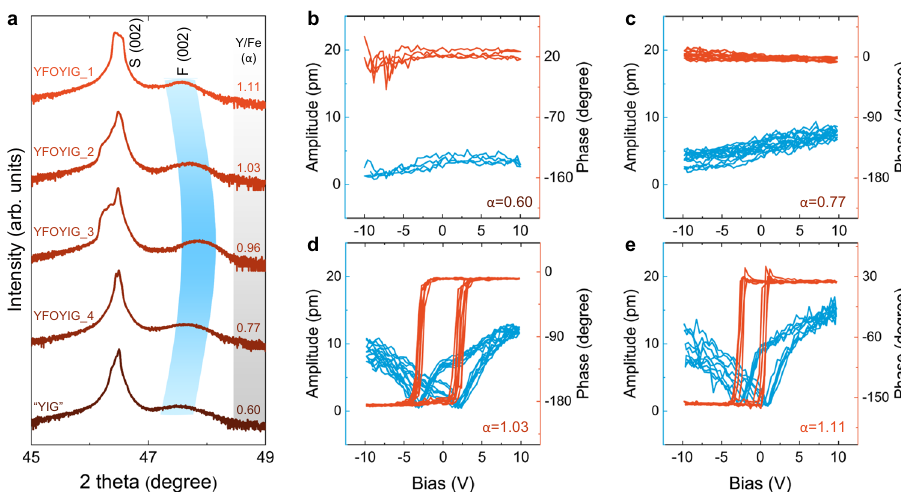
Fig. 3 Dependence of structure and ferroelectric switching on the Y/Fe ratio. a High-resolution XRD pattern of the 002 family of peaks of the fi lm deposited from the YIG target and co-deposited Y α FeO 1.5( α + 1) fi lms grown on NSTO substrates. S and F refer to the peaks of substrate and fi lm. The Y/Fe ratio, i.e., α , determined by high-resolution XPS analysis is labeled correspondingly. b – e Local SS-PFM amplitude curves and phase loops of “ YIG ” fi lms ( α = 0.60) ( b ) and co-deposited Y fi lms with α = 0.77 ( c ), 1.03 ( d ), and 1.11 ( e ), respectively. α FeO 1.5( α + 1) thin